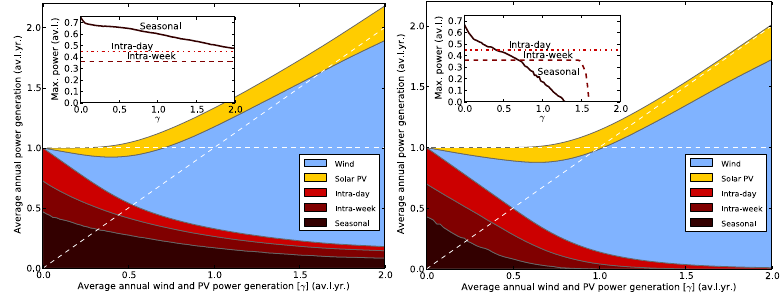
Fig. 4. Average annual power generation of the flexible intra-day, intra-week, and seasonal systems vs. average annual combined wind and solar PV power generation in units of an average load year (av.l.yr.). The average power generation of wind and solar are shown as well. The inset shows the corresponding power capacities of the three flexible systems. Two cases are shown: closed borders (left panel), i.e., no power transmission across the national borders, and, open borders (right panel), i.e., unlimited power transmission between all countries.